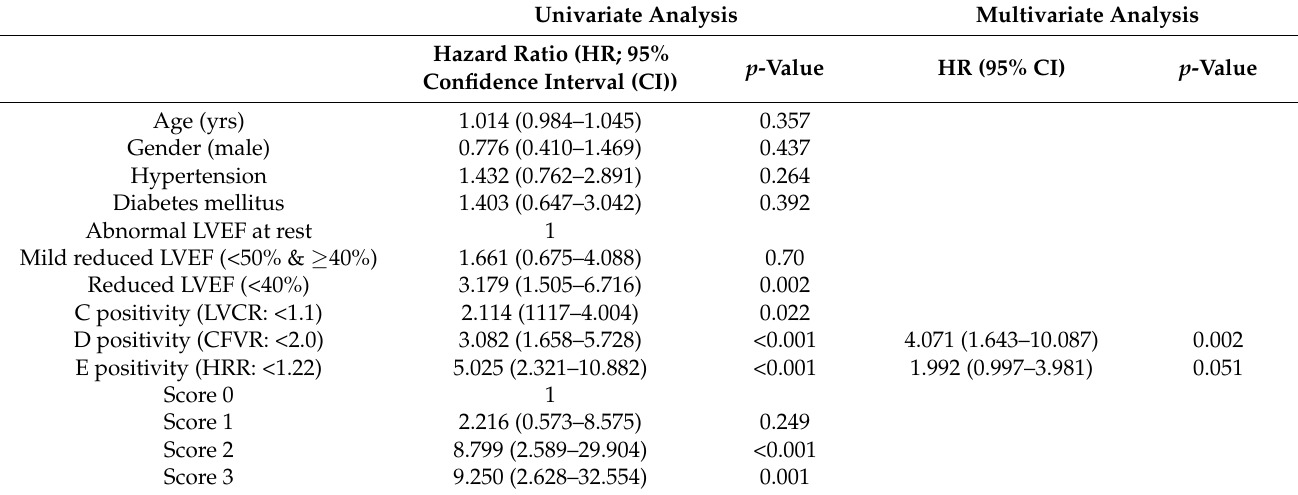
Table 3. Univariate and multivariate predictors of all-cause of death. Univariate Analysis Multivariate